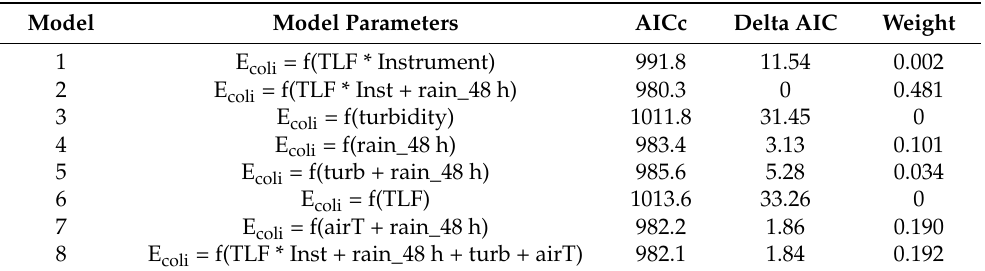
Table 2. List of linear models used for each AIC model selection in R and AIC results; f( ) indicates that a model is a function of the listed parameters. “E coli ” = E. coli concentration; “TLF * Inst” = interaction variable between TLF and the instrument used to record it; “rain_48 h” = 48 h antecedent rainfall; “turb” = turbidity; “TLF” = TLF concentration; and “airT” = air temperature.